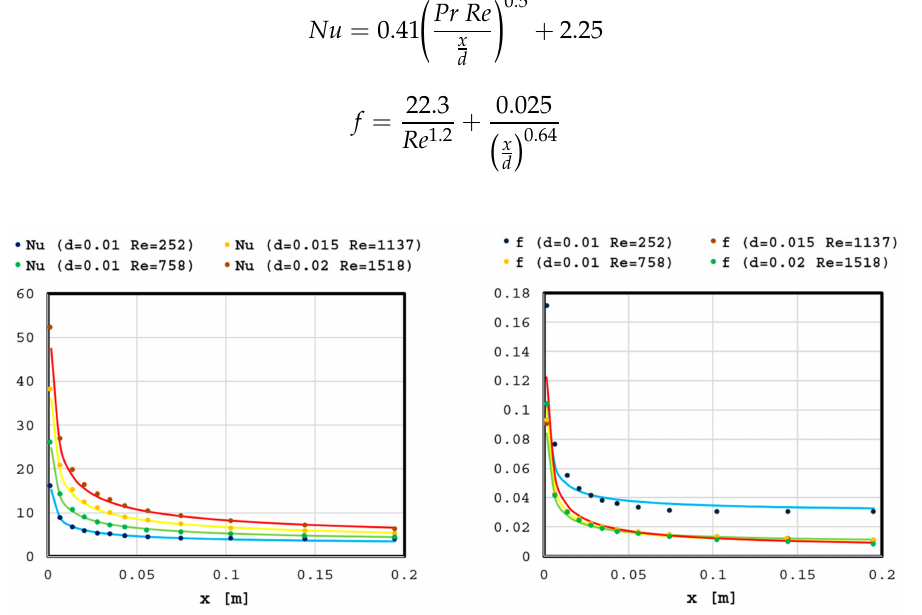
Figure 9. Comparison between conjugate heat-transfer analysis (dots) and regression equation (lines) under variable diameter and Reynolds number. Nusselt number ( left ); Friction factor ( right